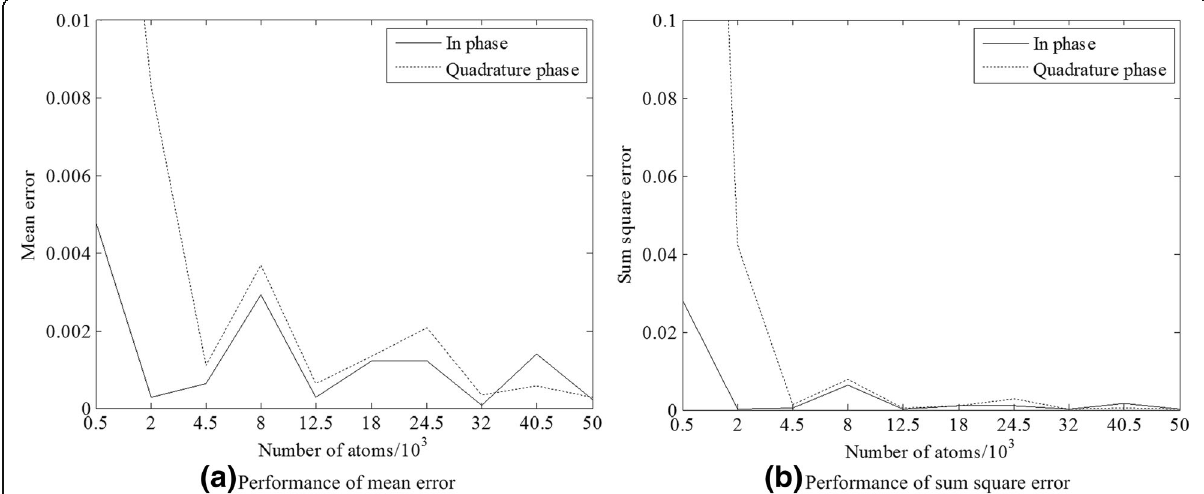
Fig. 6 Effect of atom numbers to ME and SSE. The MS and SSE are employed as an evaluation indicator, whose performance has correlation with